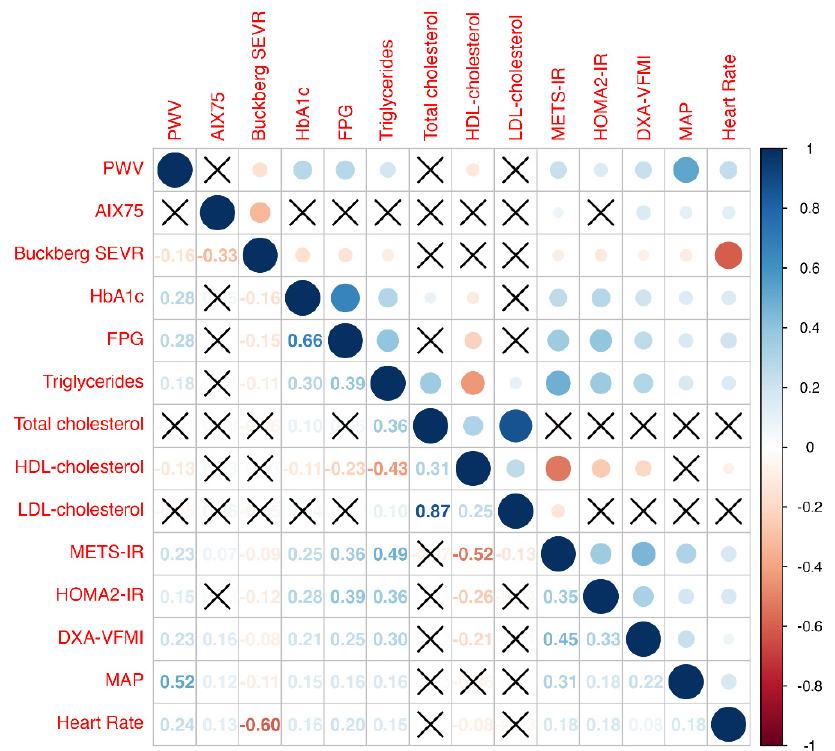
Figure A2. Linear correlation matrix between cardiovascular (PWV, AIX75, Buckberg, SEVR, MAP, and HR) and metabolic parameters. Non-significant correlations are crossed out. Variables were standardized and normalized using the ordered quantile (ORQ) normalization of the BestNormalize R package.